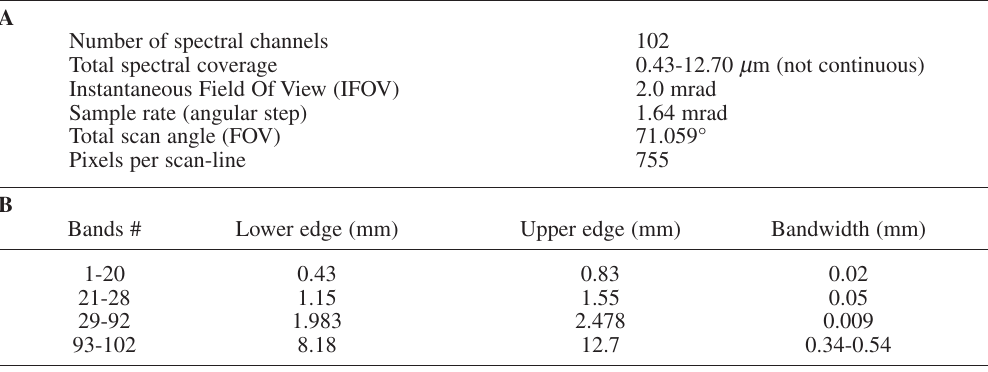
Table I. MIVIS sensor technical details (A) and related spectral range